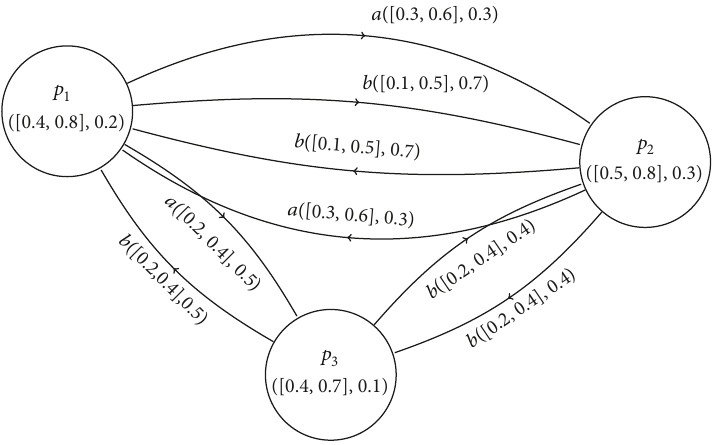
Figure 3: A commutative cubic fsm T = ⟨ P ,𝑋, 𝜑⟩